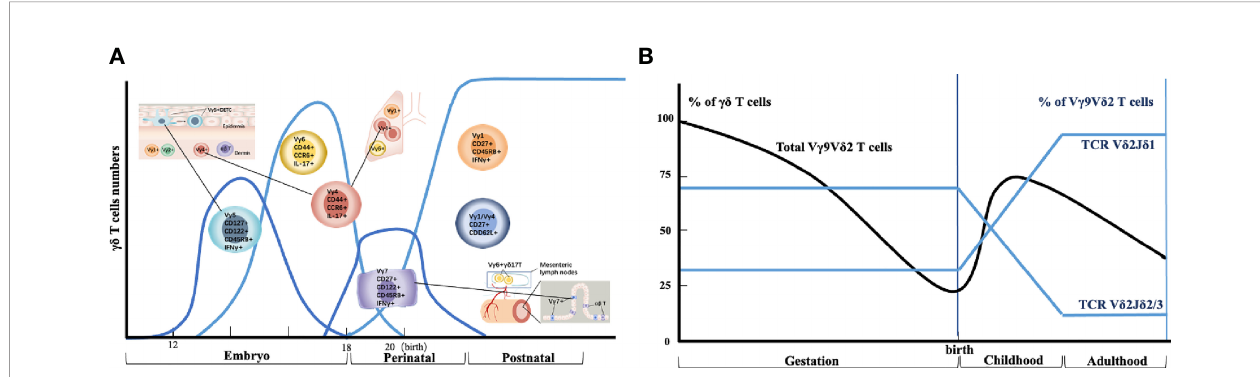
FIGURE 1 | Thymic developmental waves and tissue homing of human and mouse gd T cell subsets. (A) Different waves of gd T cell progenitor subsets are produced in speci fi c developmental windows in the thymus and selectively home to different organs. (B) Schematic depiction of human V g 9V d 2 + T cell generation and selection throughout